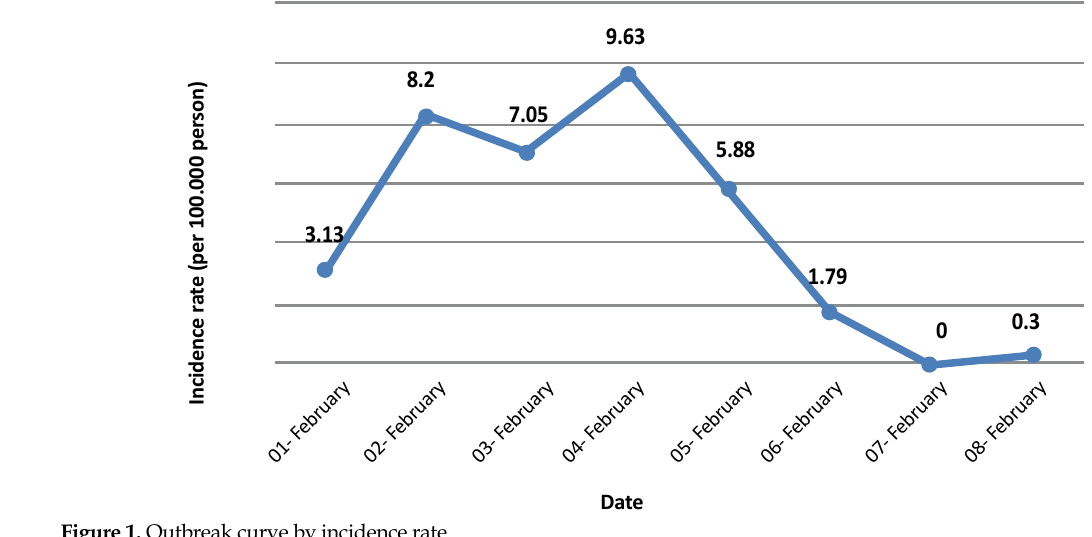
Figure 1. Outbreak curve by incidence rate *Feb: